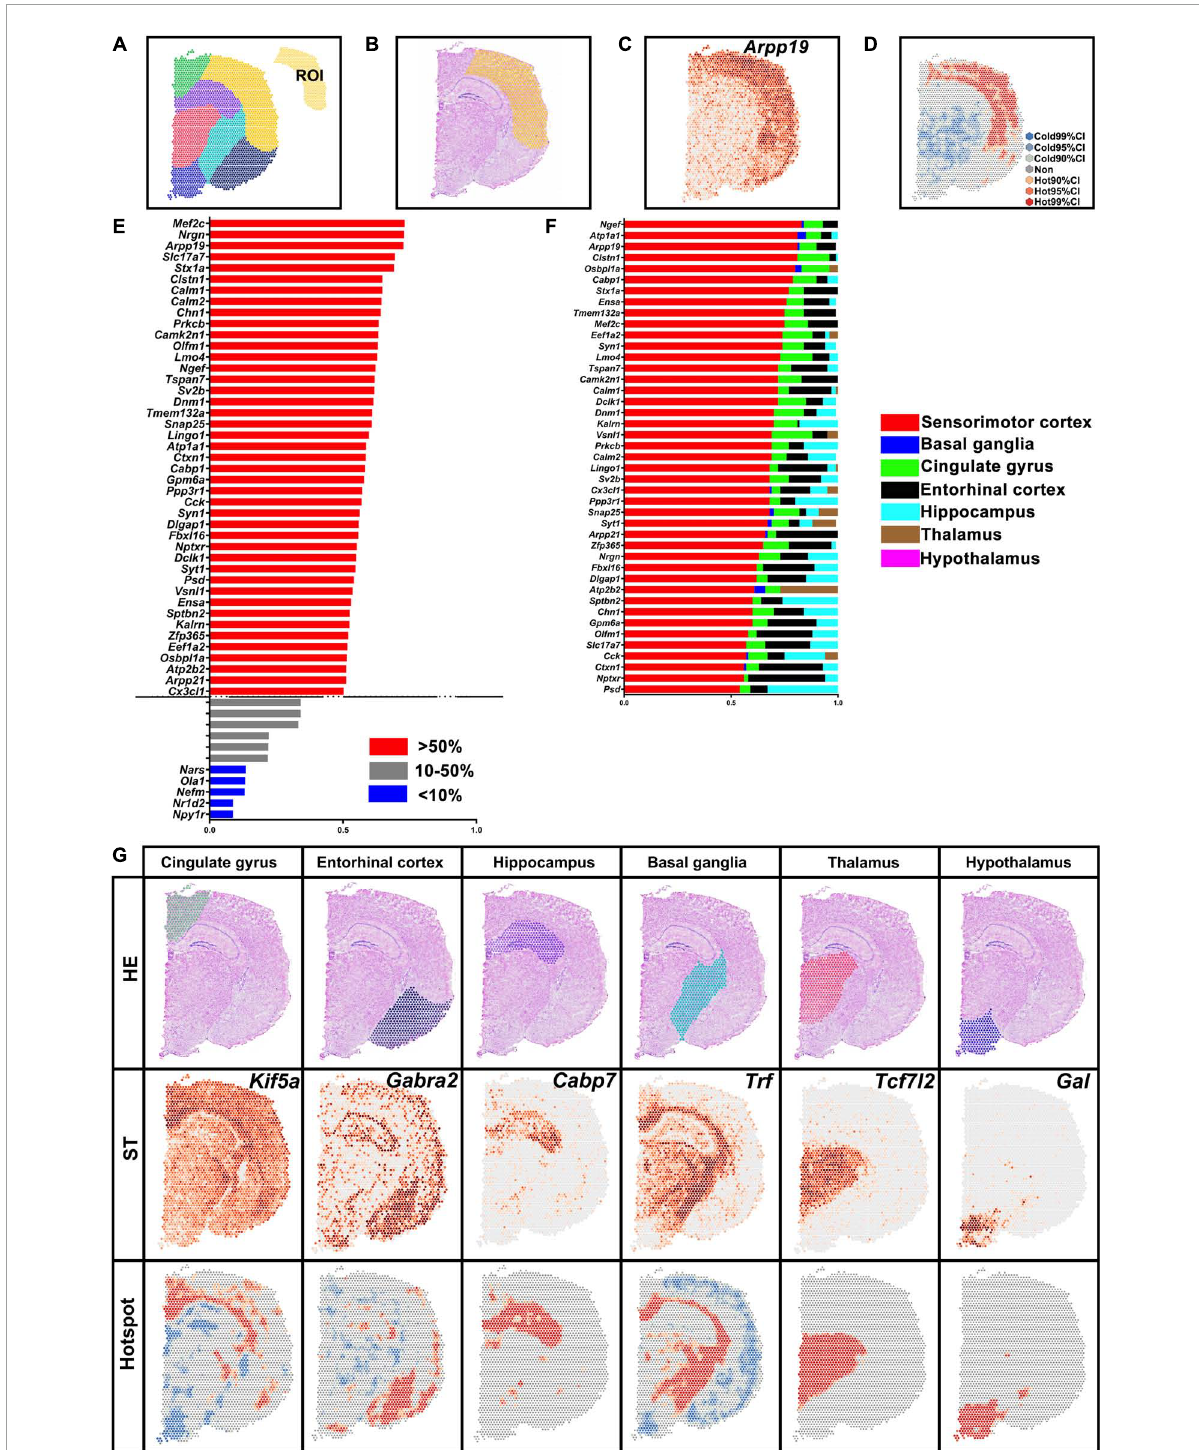
FIGURE3 Differentially expressed genes (DEGs) in the different brain regions. (A) Brain region. ROI indicates sensorimotor cortex. (B) Yellow area indicates sensorimotor cortex in HE images. (C) Arpp19 of ST map. (D) Hotspot of Arpp19 . (E) DEGs in the sensorimotor cortex. Ratio = The number of H-H spots in sensorimotor cortex/The total number of spots in the section. (F) Septicity of DEGs in the sensorimotor cortex. Ratio = The number of H-H spots in each region/The total number of H-H spots. (G) Marker genes of each brain region. ST, spatial